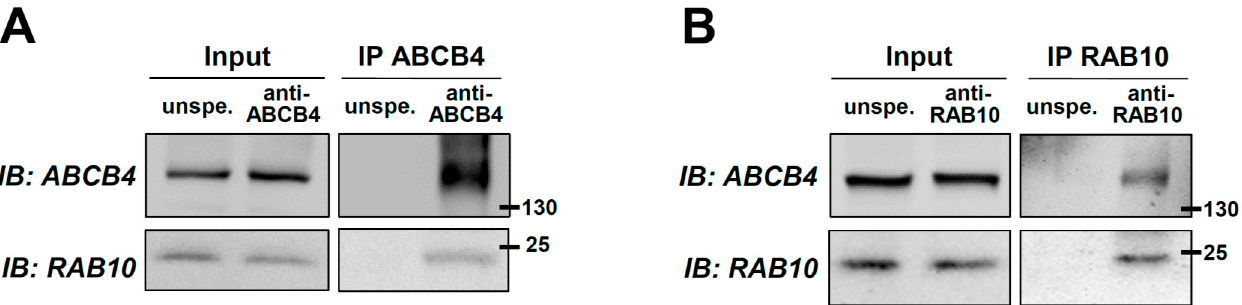
Figure 1. Co-immunoprecipitation of ABCB4 and RAB10 in primary human hepatocytes. ( A , B ) ABCB4 (A) or RAB10 (B) were immunoprecipitated from primary human hepatocyte lysates using specific antibodies. Controls were performed using unspecific antibodies (unspe.). After SDS-PAGE, the presence of ABCB4 and RAB10 in the lysates (Input) and the immunoprecipitates (IP) was detected by immunoblot (IB) as indicated. Molecular weight markers (in kDa) are indicated. These panels are representative of at least three independent experiments per condition. The presented data were cropped from full immunoblots shown in Supplementary Figure S2.